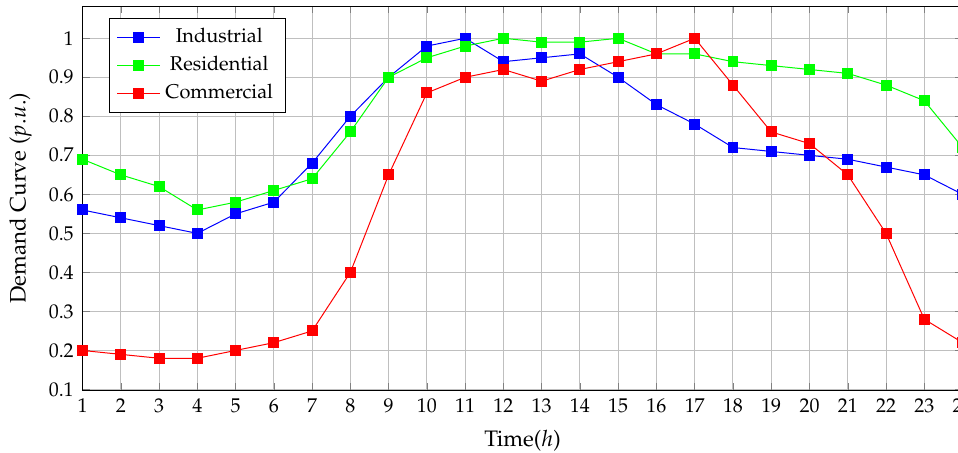
Figure 4. Load curves: industrial, commercial, and